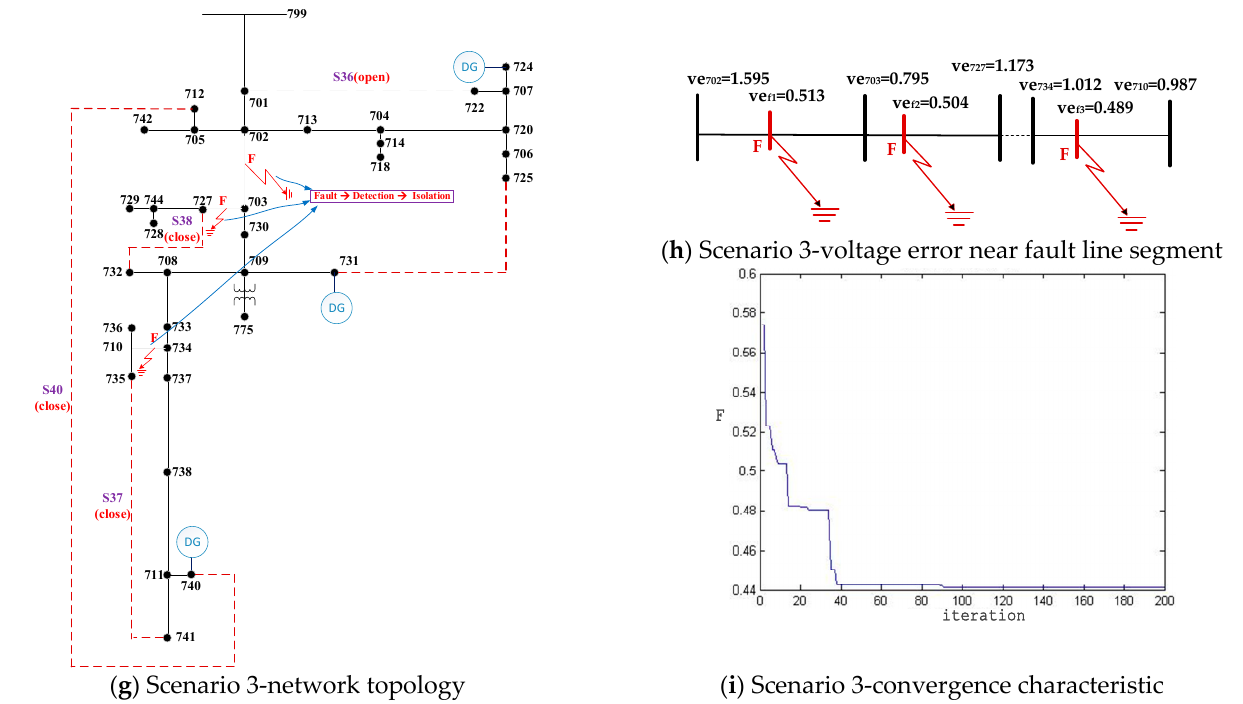
Figure 7. Network topologies, voltage errors, and convergence characteristics of the sample system after service restoration. Table 3. Simulation results under grid-tied operation mode.